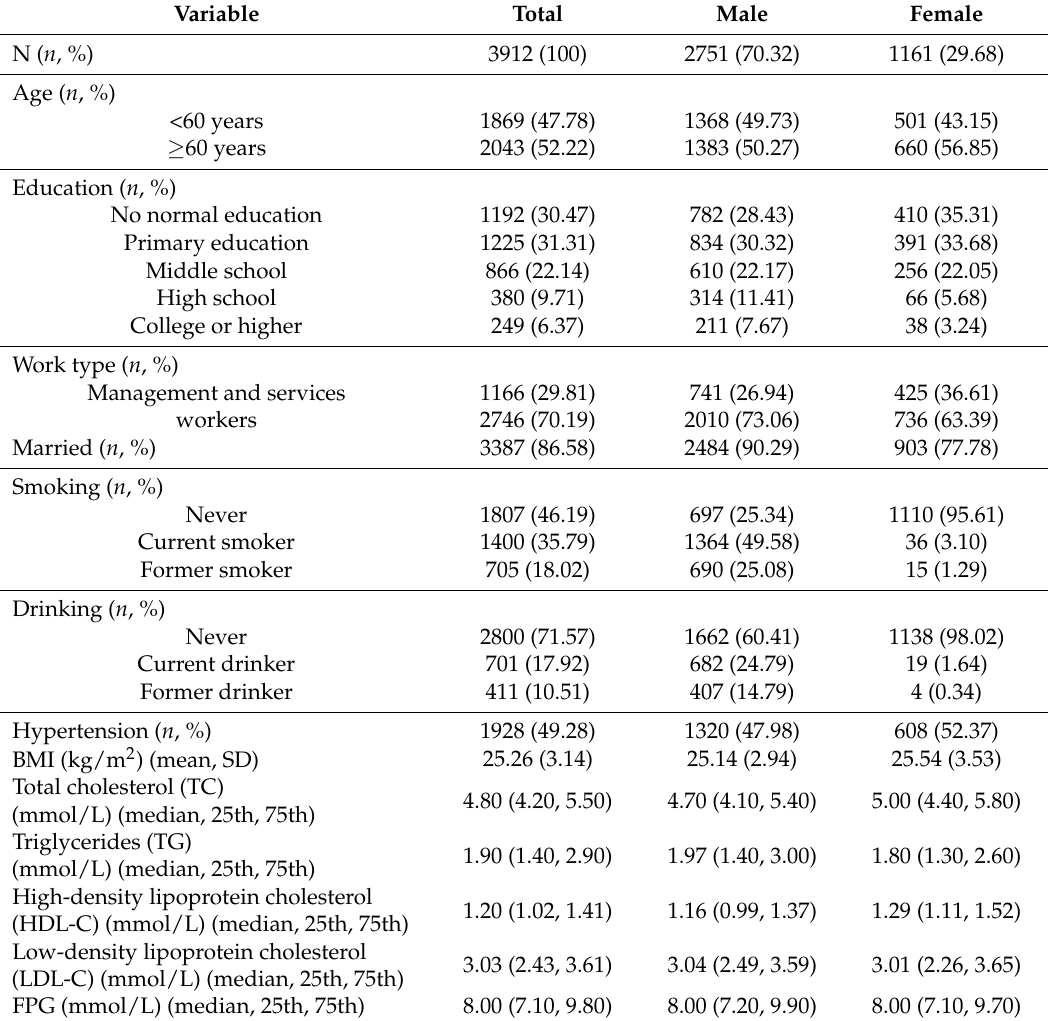
Table 1. Baseline characteristics of the 3912 type 2 diabetes